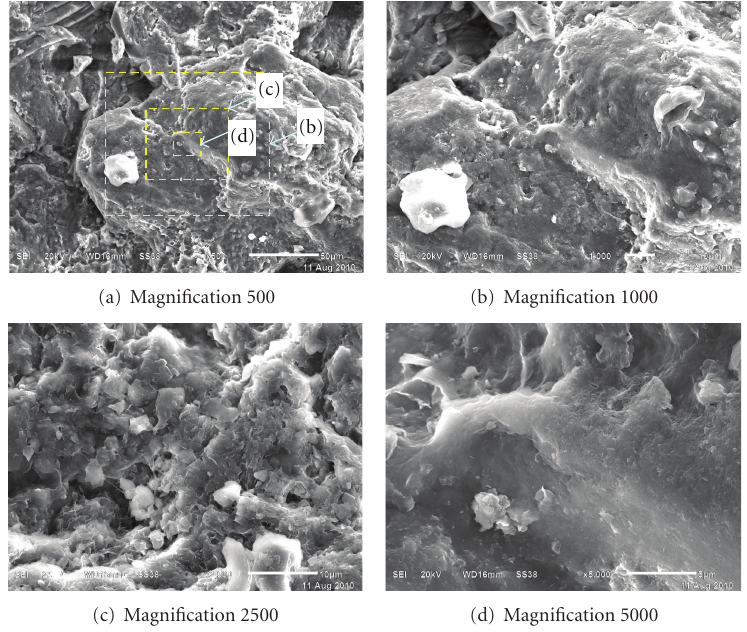
Figure 5: SEM images of red sandstone with di ff erent